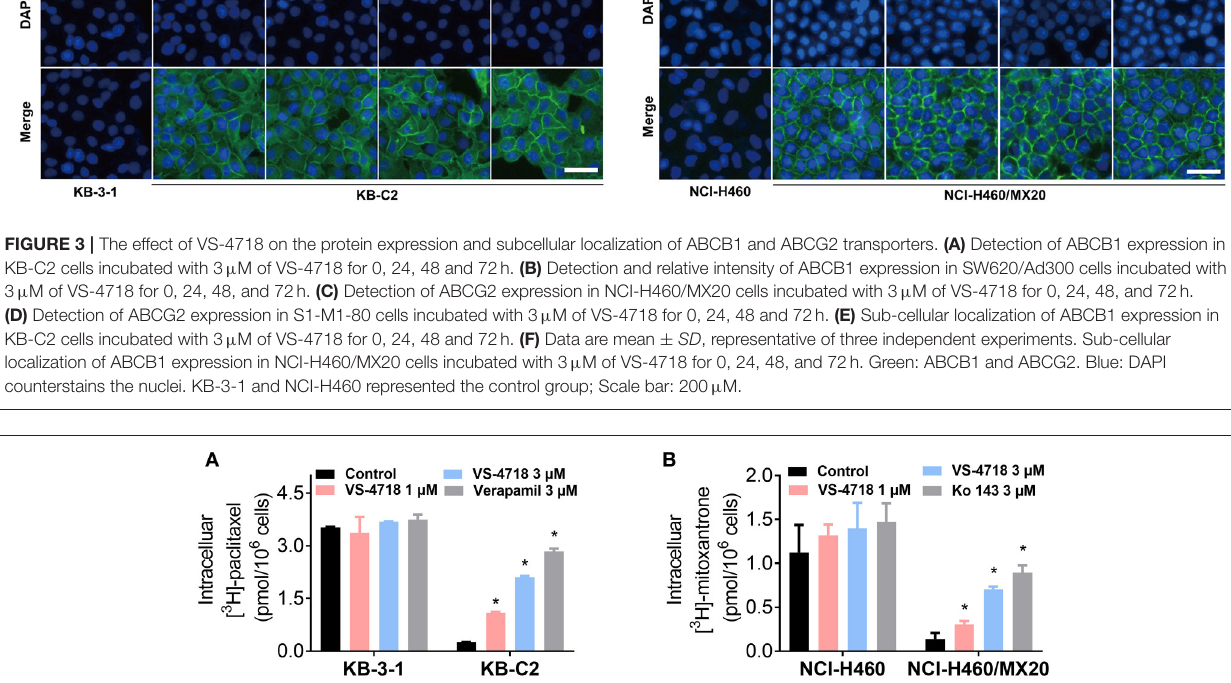
FIGURE 4 | VS-4718 increased the intracellular [ 3 H]-drug accumulation in cancer cells overexpressing ABCB1 and ABCG2. (A) The effect of VS-4718 on the accumulation of [ 3 H]-paclitaxel in KB-3-1 and KB-C2 cells. (B) The effect of VS-4718 on the accumulation of [ 3 H]-mitoxantrone in NCI-H460 and NCI-H460/MX20 cells. Verapamil (3 µ M) and Ko 143 (3 µ M) were used as positive controls for ABCB1 or ABCG2 overexpressing cells respectively. Data are mean, representative of three independent experiments. * p < 0.05, compared with control